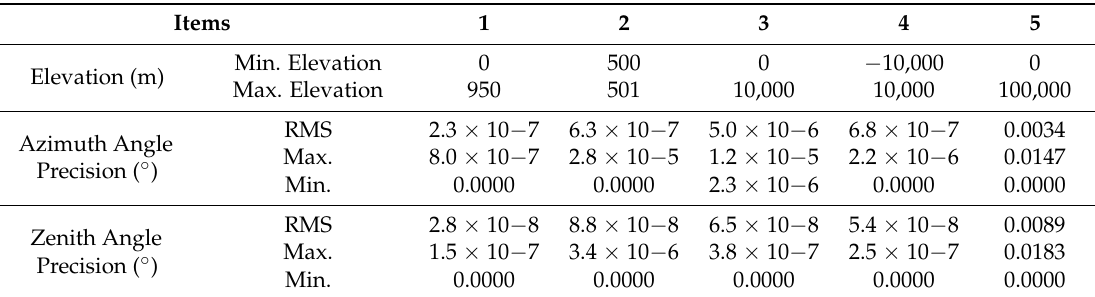
Table 2. Precision of ZY3-02 panchromatic nadir (NAD) viewing angles calculated from the Rational Function Model (RFM) at planes of different